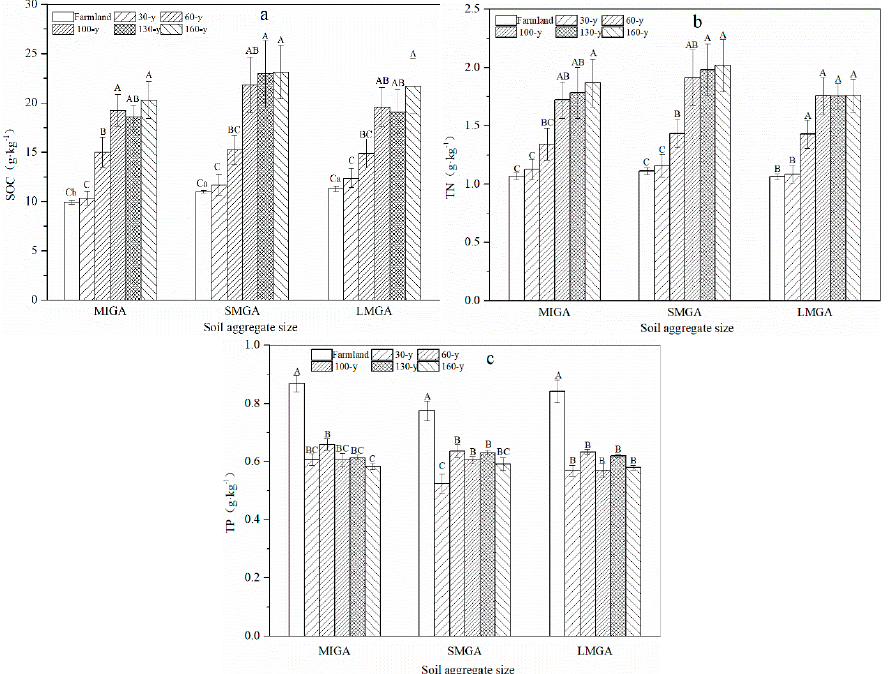
Figure 3. Changes in soil organic carbon (SOC) ( a ), total nitrogen (TN) ( b ), and total phosphorus (TP) ( c ) in different sizes of soil aggregates with the vegetation succession. MIGA: microaggregate, SMGA: small macroaggregate, LMGA: large macroaggregate. Error bars denote Standard error. Letters above the bars are for comparison in the size of the same aggregate at the different restoration stages, bars with the same letter are not significantly different at p = 0.05.